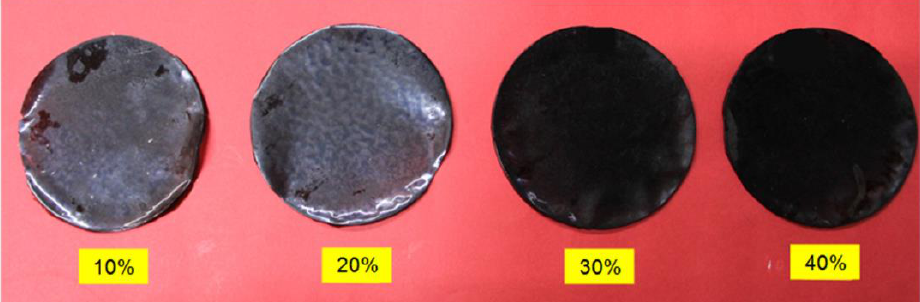
Figure 3. Pictomicrographs of DNG/Ch/MH (dextran/nanosoy/glycerol/chitosan with Manuka honey) dressings at different drug concentrations (10 – 40%). Reproduced from International Journal of Biological Macromolecules 120 (2018) 1581-1590; Singh et al., Scar-free healing mediated by the release of aloe vera and Manuka honey from dextran bionanocomposite wound dressings (reproduced with permission from [166], Elsevier, 2018).